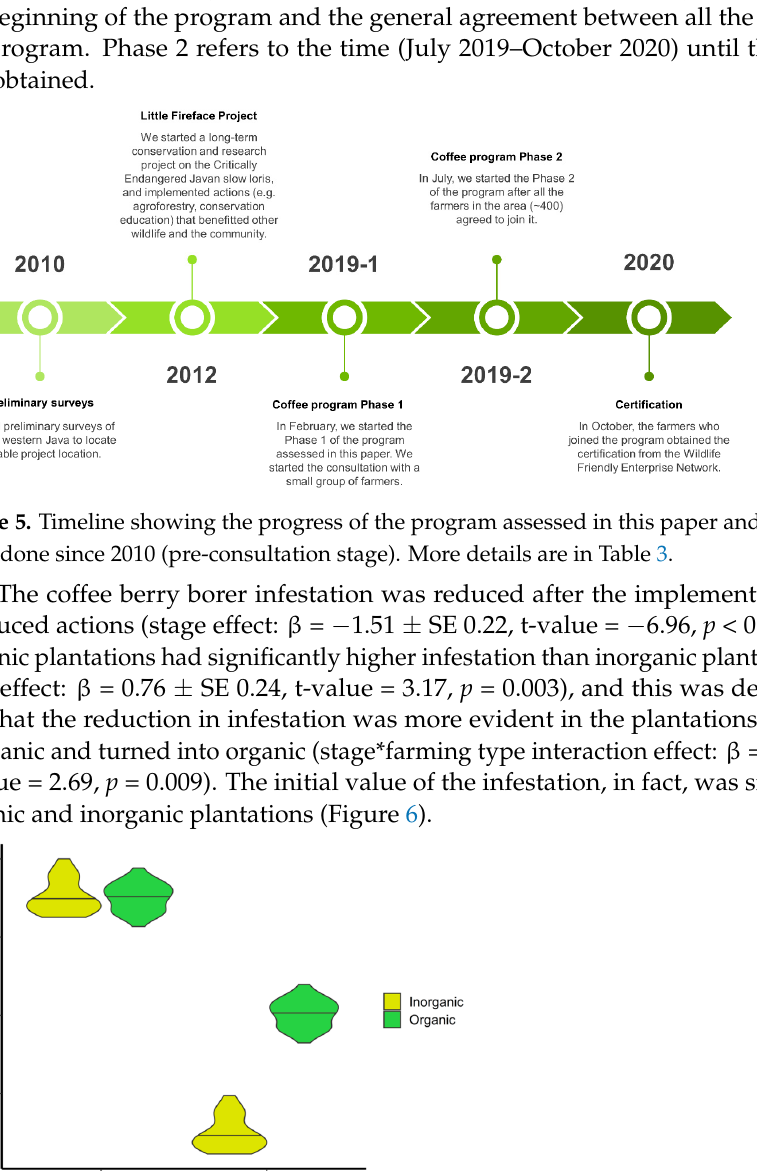
Figure 6. Violin plot representing the decrease in coffee berry borer infestation in 28 organic and 28 inorganic coffee fields in Cipaganti and Pangauban, West Java. We did the assessment before (May 2019) and after (May 2020) we implemented the coproduced actions meant to reduce the coffee berry borer. The inorganic plantations turned into organic during the process, starting in July 2019. Filled areas indicate density of data, lines indicate median values.